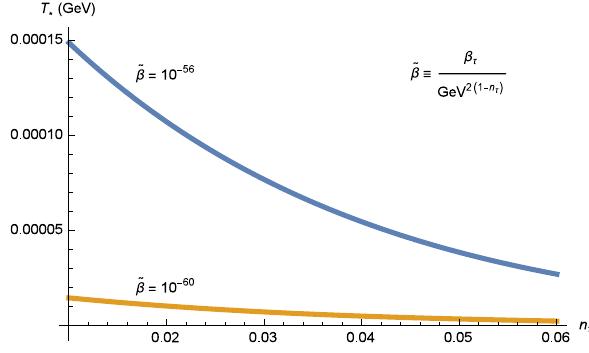
Fig. 1 (cid:12) vs n .Forfixedvaluesof η = 1and β T ,thevalueof (cid:12) needed to explain DM relic abundance and IceCube data follow for n T ∼ 0 . 25